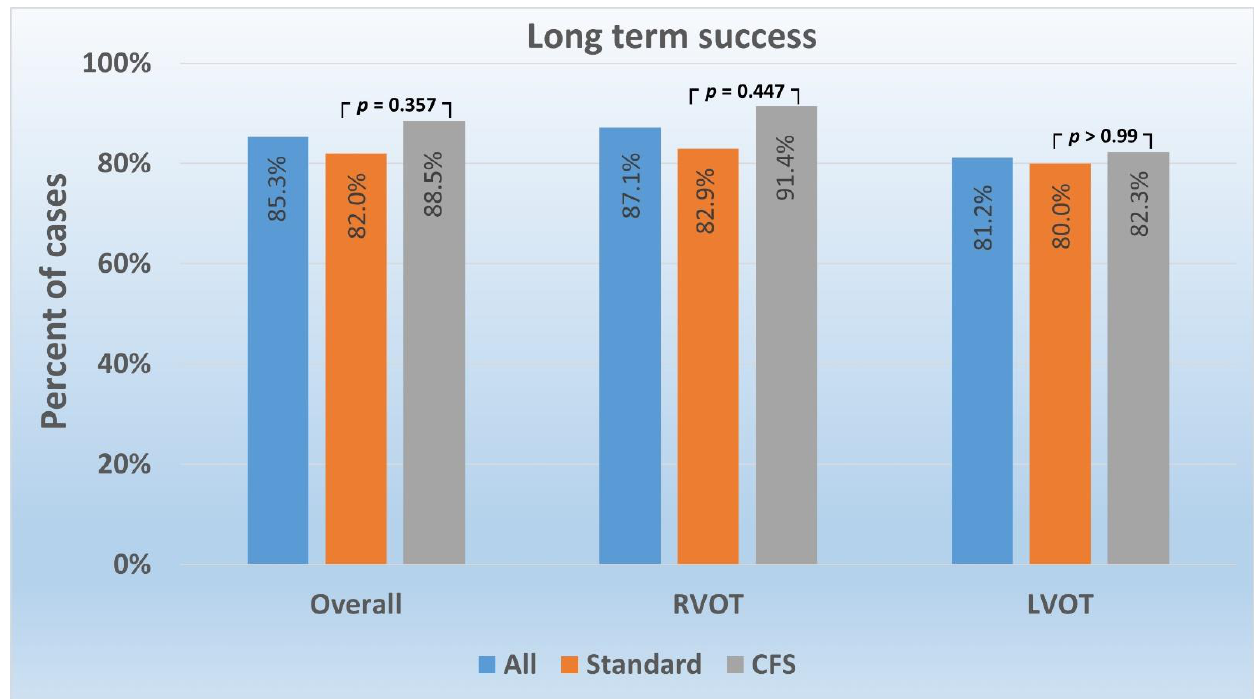
Figure 4. Premature ventricular contraction ablation long-term success according to catheter type and arrhythmia localization. Abbreviations: CFS—contact force-sensing; LVOT—left ventricular outflow tract; RVOT—right ventricular outflow tract.